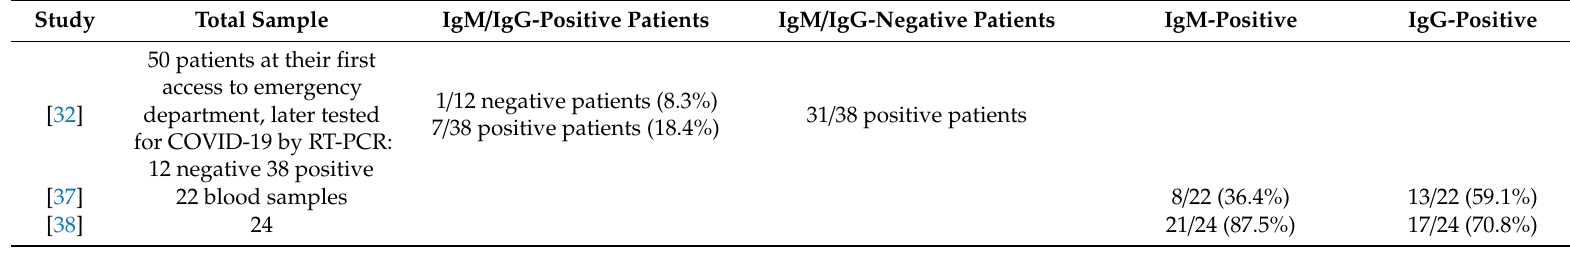
Table 4. Anti-SARS-CoV-2 IgM and IgG rates in patients with suspected infection / fever and respiratory syndrome (positivity to COVID-19 not confirmed by RT-PCR).